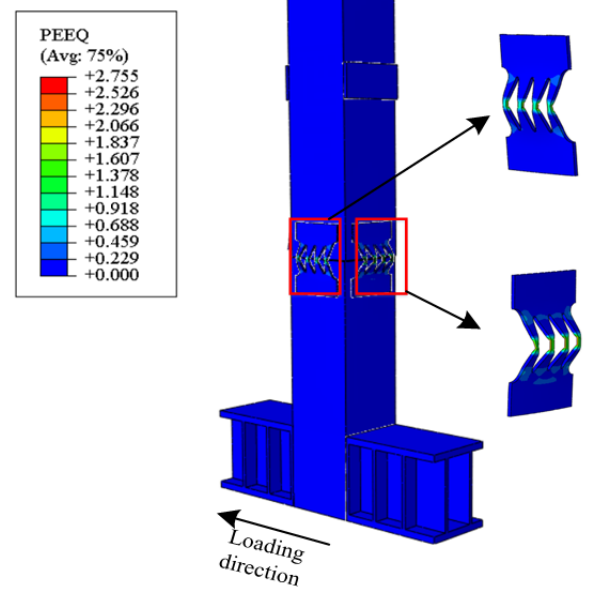
Figure 4. PEEQ (equivalent plastic strain nephogram) of CFST pier and energy dissipator.